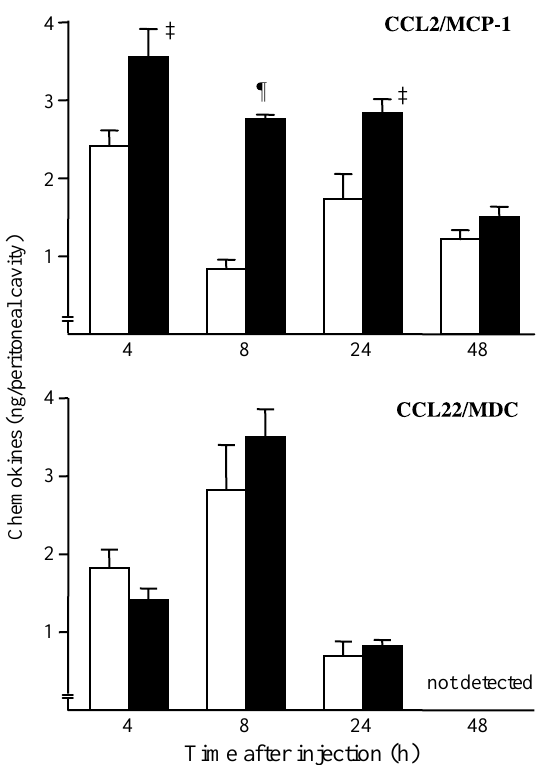
FIG. 3. Effects of anti-CCL6 treatment on CC chemokine production. Either 0.5 ml of anti-CCL6 antiserum (closed columns) or control serum (open columns) was intraperito- neally injected 2 h prior to thioglycollate injection. At indicated intervals after thioglycollate injection, mice were euthanized and the peritoneal fluids were harvested (each group, 10 mice), and levels of CCL2 and CCL22 were measured by ELISAs. % p B / 0.05, ’ p B / 0.0001, when compared with control.